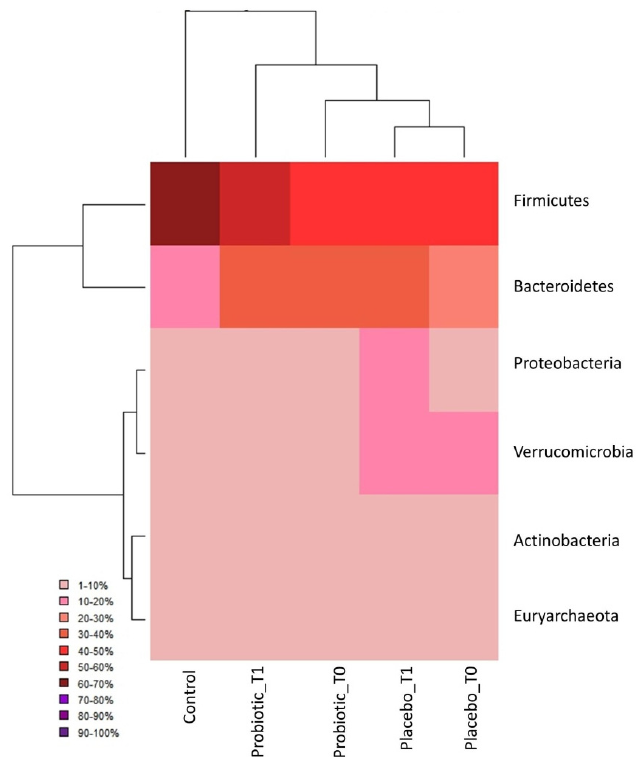
Figure 2. Hierarchically clustered heat map: Sample groups are reported in column, while phyla are reported in row.